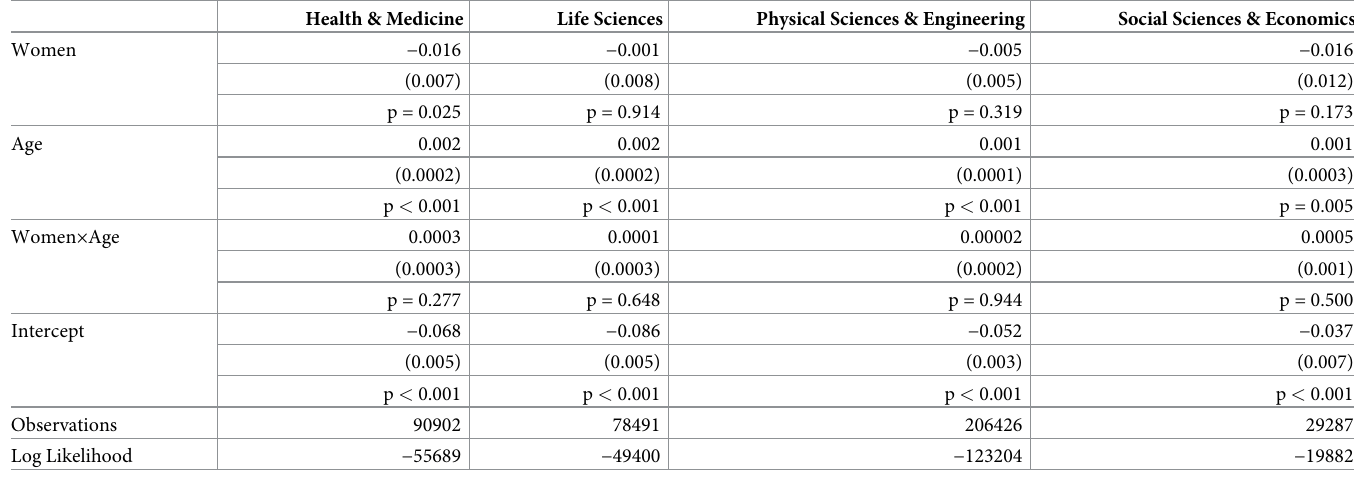
Table 6. Mixed effects models predicting February-May 2020 changes in the proportion of accepted review invitations per area of